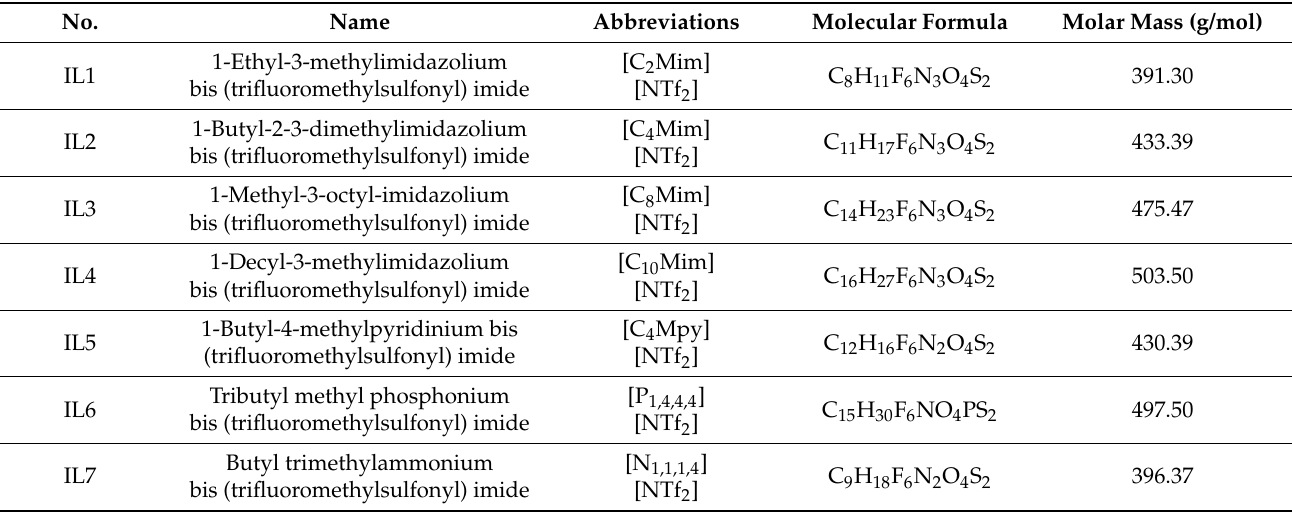
Table 1. Thermophysical properties of the ILs tested in this work.